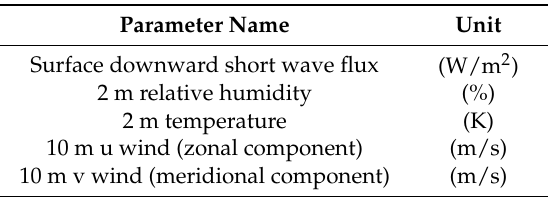
Table 1. List of meteorological parameters that were